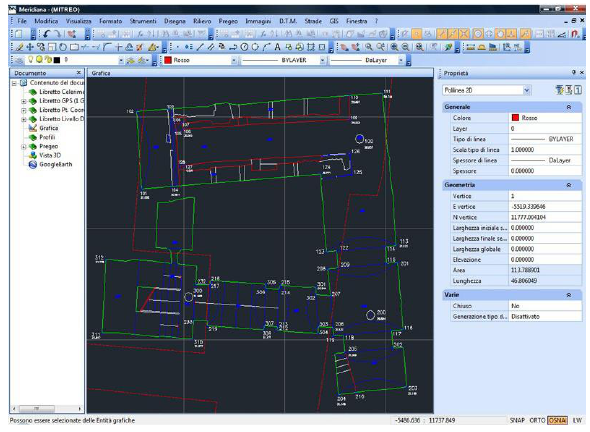
Figure 9. Orientation of the stations referred to a local system and then anchored to points of